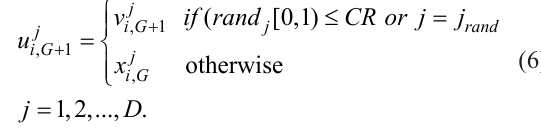
number between 0 and 1. LB and UB are two vectors of lower bound and upper bound for any decision